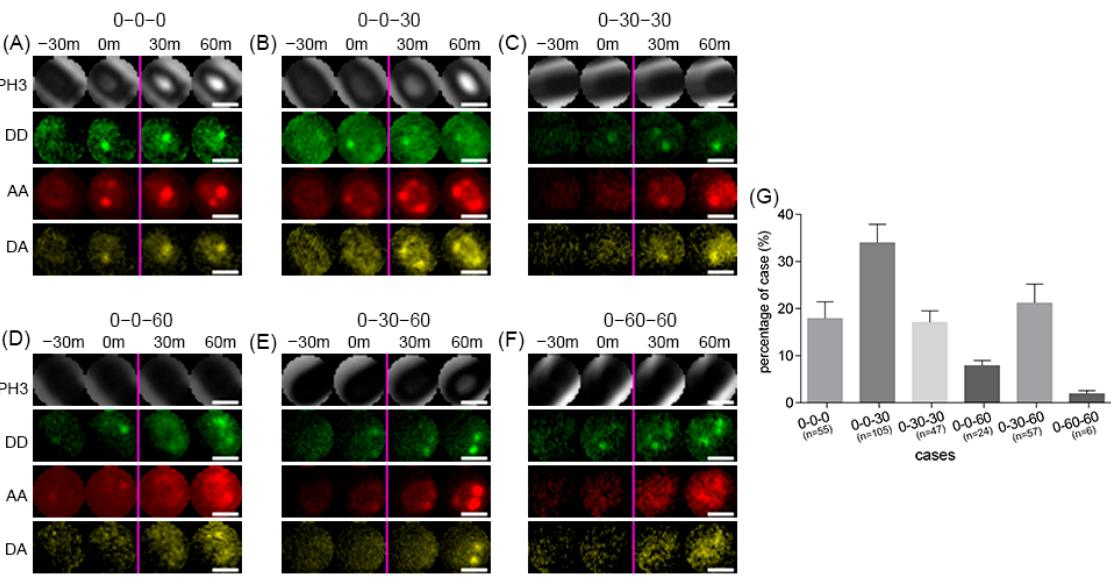
Figure 7. Dynamics of germinosome formation during forespore development in B. cereus strain F06. The time of appearance of DD foci for the first time-point is defined as time “0”, with subsequent images taken 30 and 60 min later in each row. The categories were defined according to the first appearance of foci in the DD, AA, and DA channels. ( A ) category 0-0-0, ( B ) category 0-0-30, ( C ) category 0-30-30, ( D ) category 0-0-60, ( E ) category 0-30-60, and ( F ) category 0-60-60. ( G ) Percentages of different categories. Abbreviations: PH3, phase-contrast; DD, donor image; AA, acceptor image; DA, FRET image. Scale bar = 1 µm.